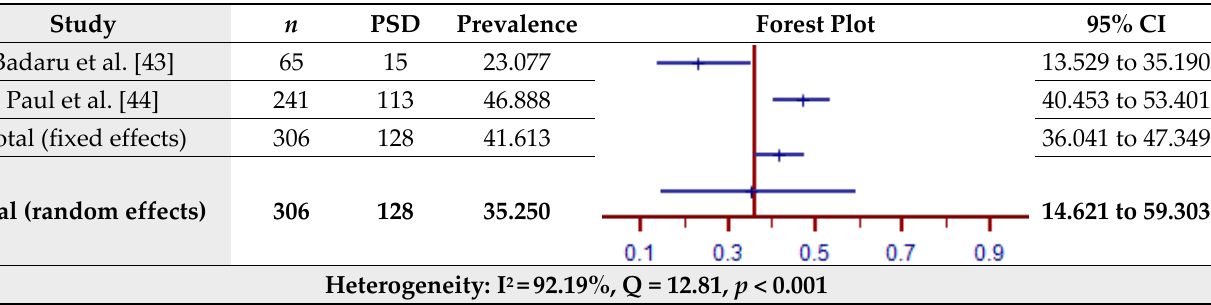
Figure 7. Prevalence estimates of Post-Stroke Depression (PSD) assessed by the Geriatric Depression Scale (GDS15/30).